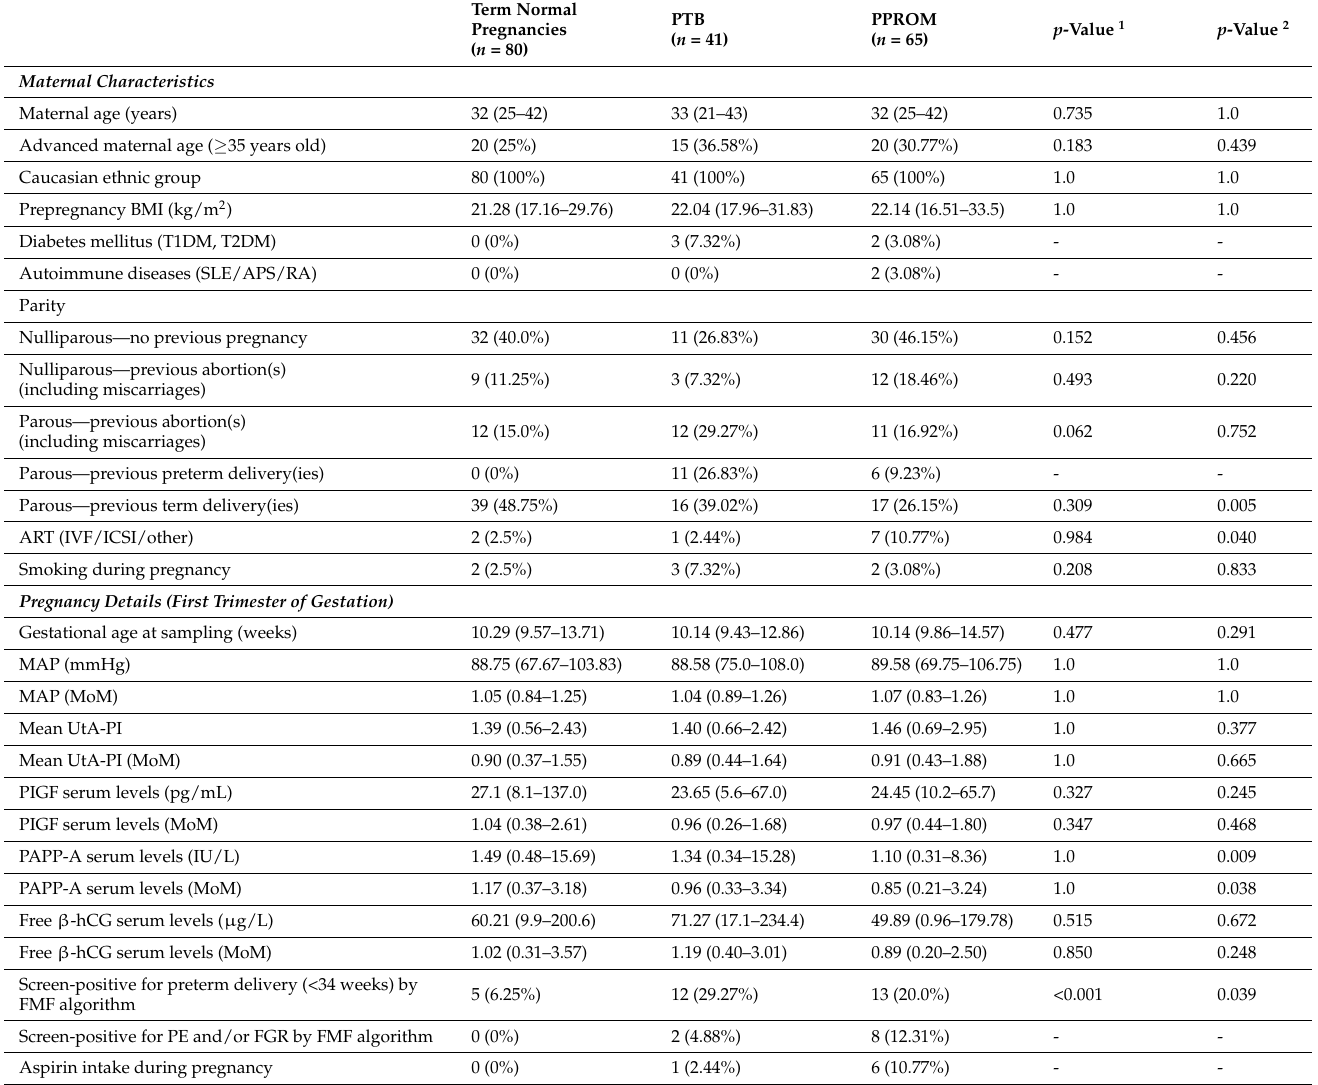
Table 1. Clinical characteristics of the cases and